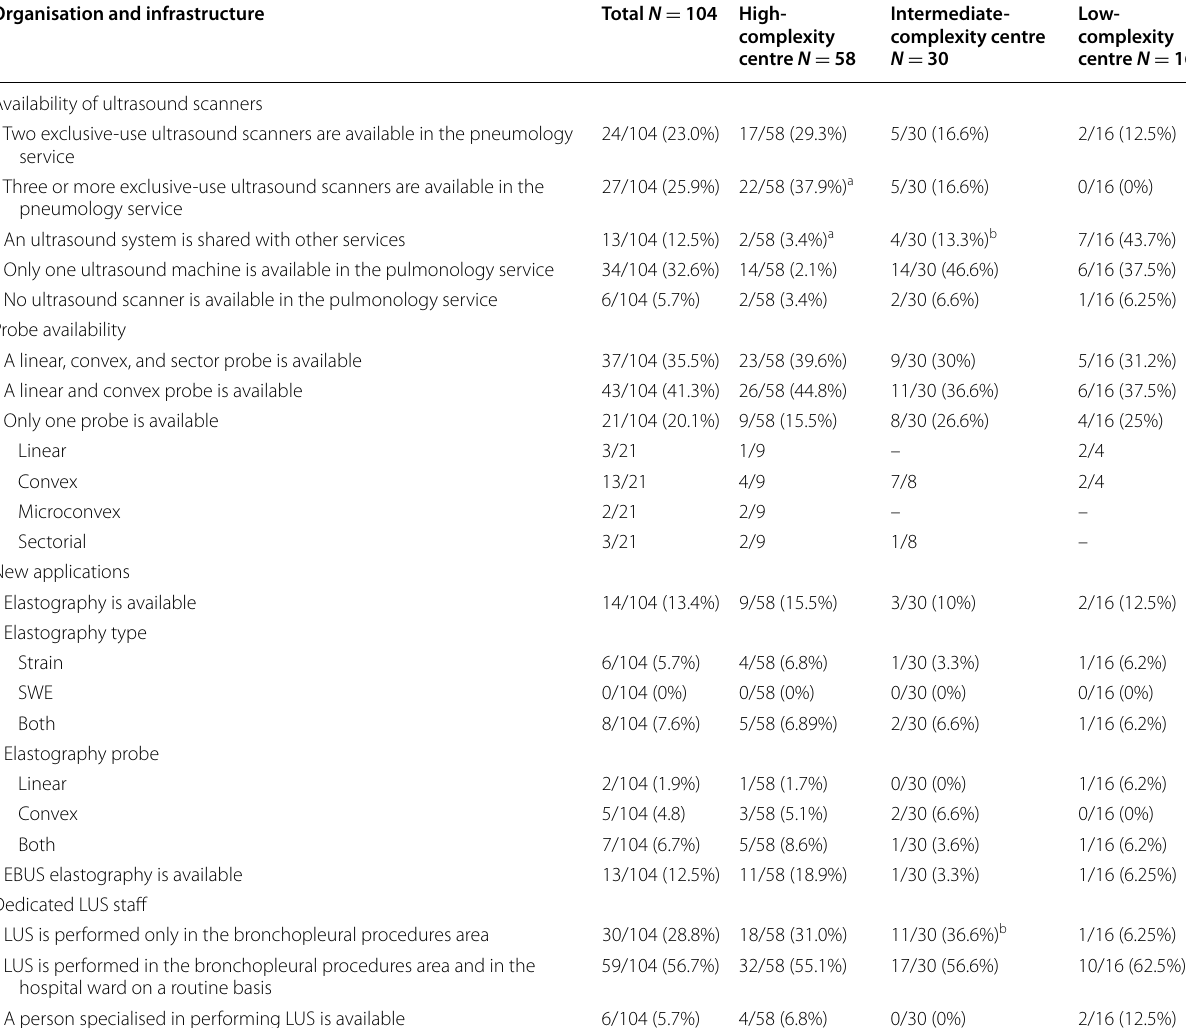
Table 1 Organisational and infrastructural factors related to the use of